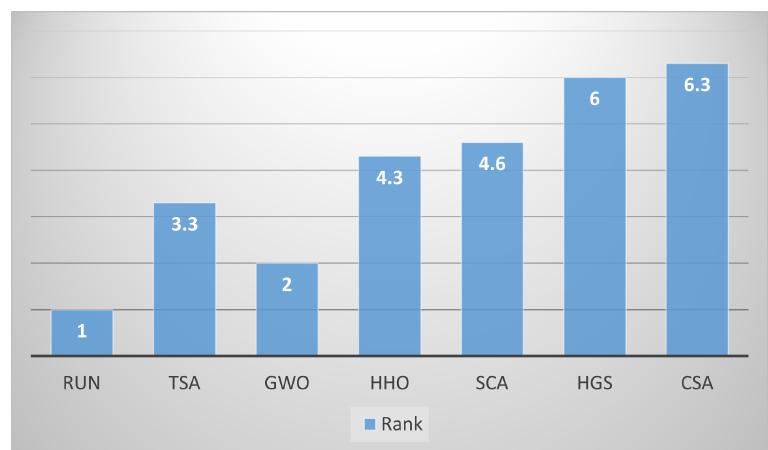
Figure 17. Friedman rank curve for DDSCM.